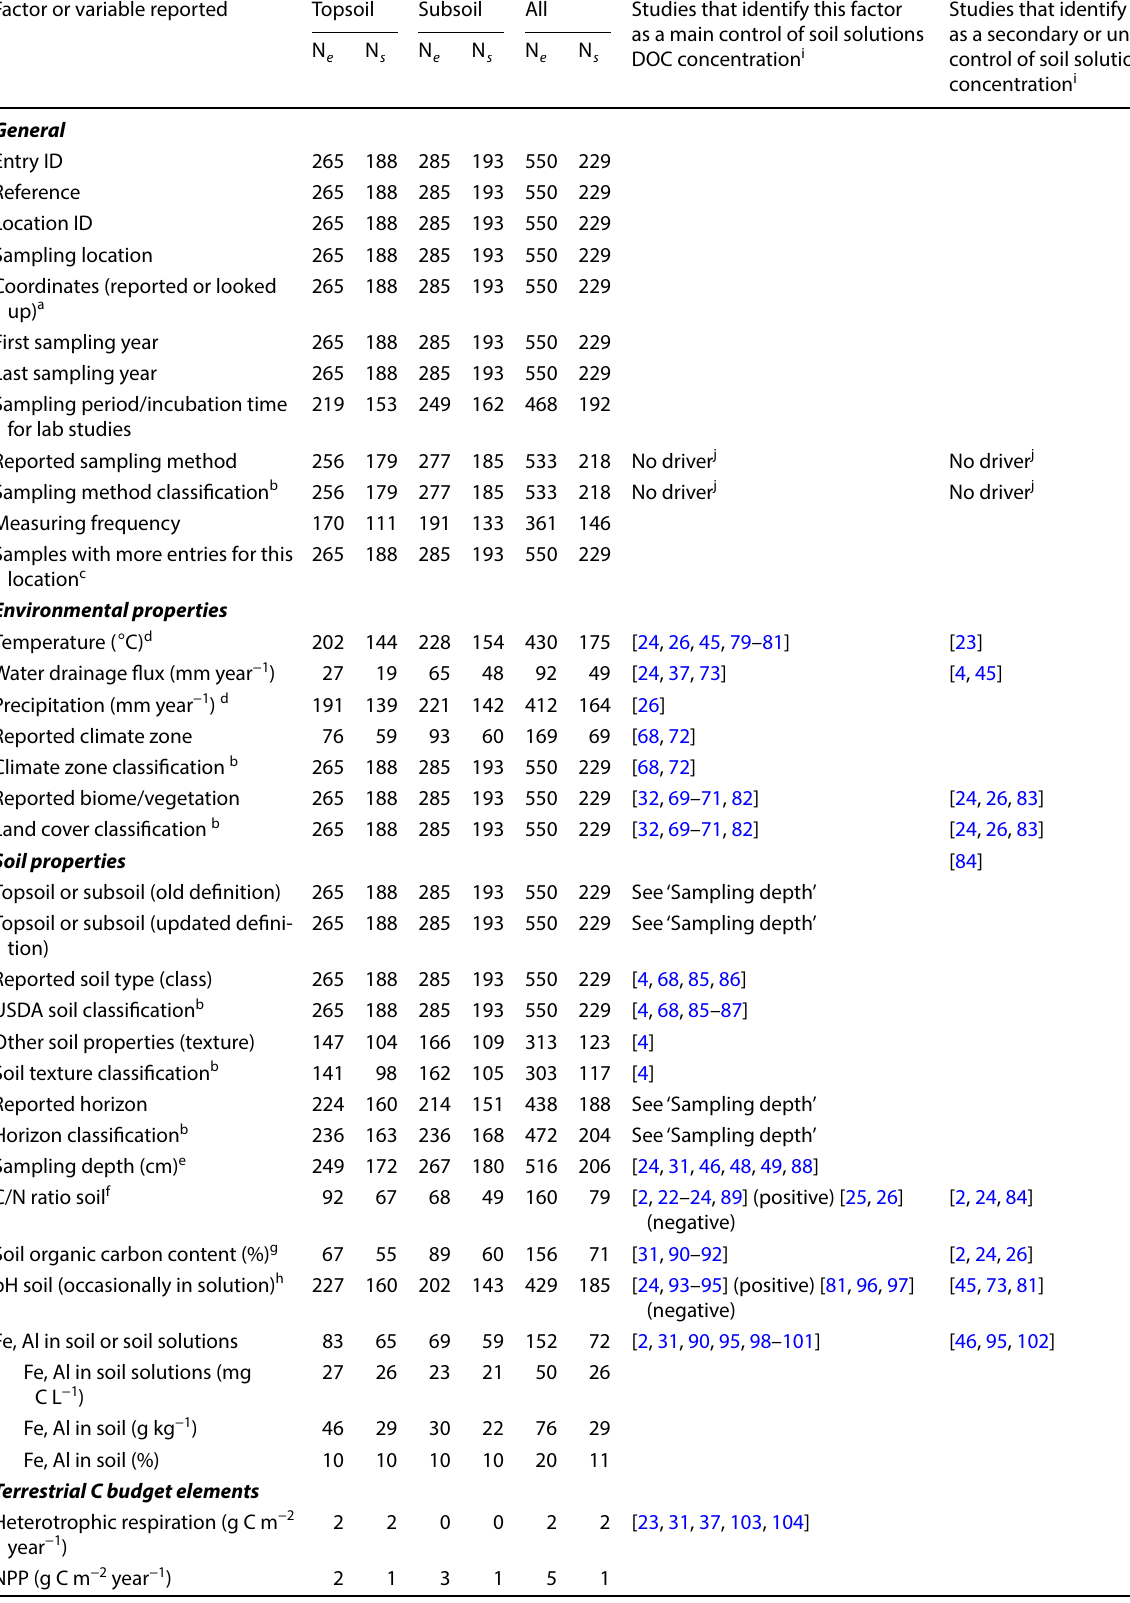
Table 2 Meta-data overview, database selection of yearly DOC concentrations (550/762 entries) Factor or variable reported Topsoil Subsoil All Studies that identify this factor Studies that identify this factor as a main control of soil solutions as a secondary or unimportant N DOC concentration i control of soil solutions DOC concentration i